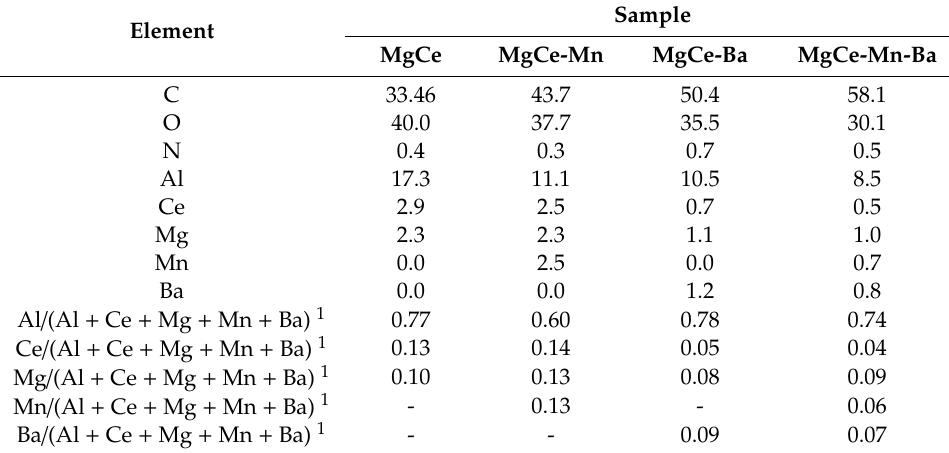
Table 3. Surface atomic contents and ratios estimated by X-ray photoelectron spectroscopy